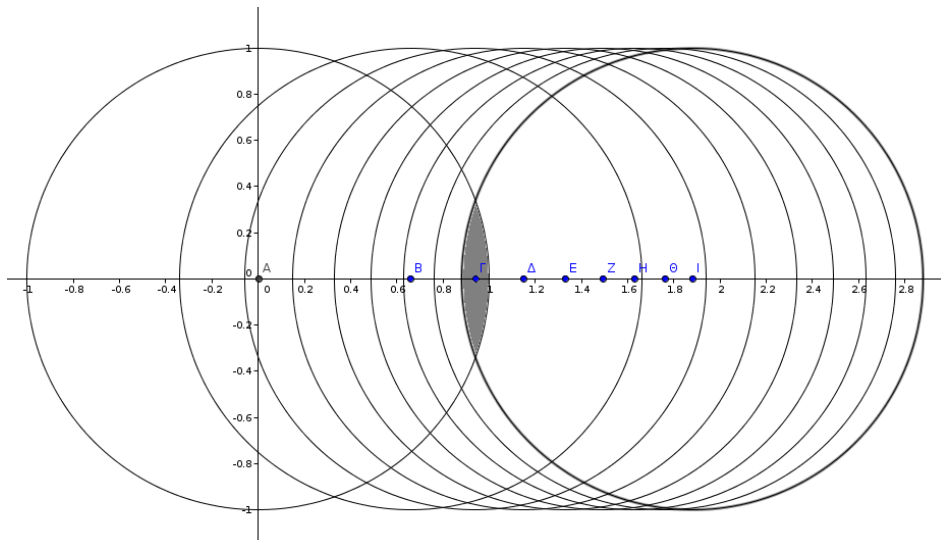
Figure 1. Common neighborhood surfaces of nodes sequentially visited by the random walker. Eventually, the random walker’s steps are not straight as in the figure; the Euclidean distance from the original node A is given by Equation (1). The colored gray area is still the overlapping surface for t =